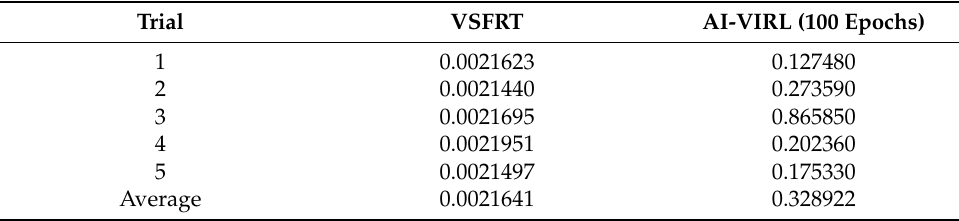
Table 8. VSFRT and AI-VIRL tracking performance when learning uses open-loop IO